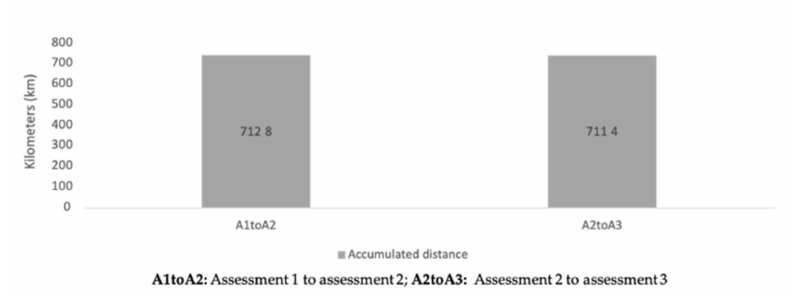
Figure 6. Accumulated distance during the periods of the season.